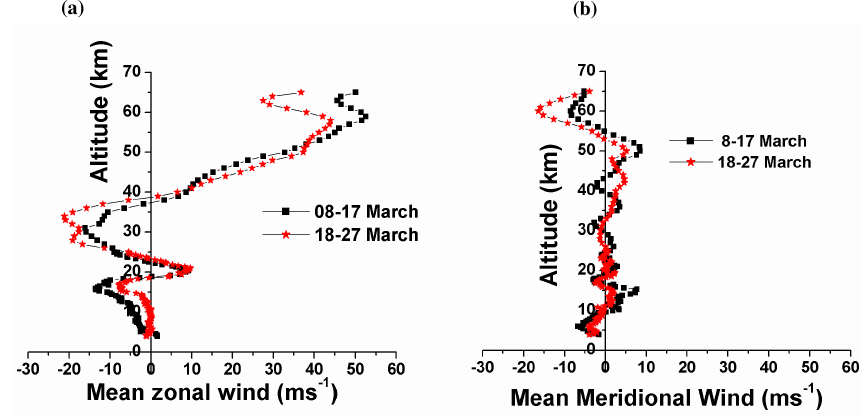
Fig. 5. Vertical profiles of mean (a) zonal and (b) meridional winds during 8–17 March 2000 and 18–27 March